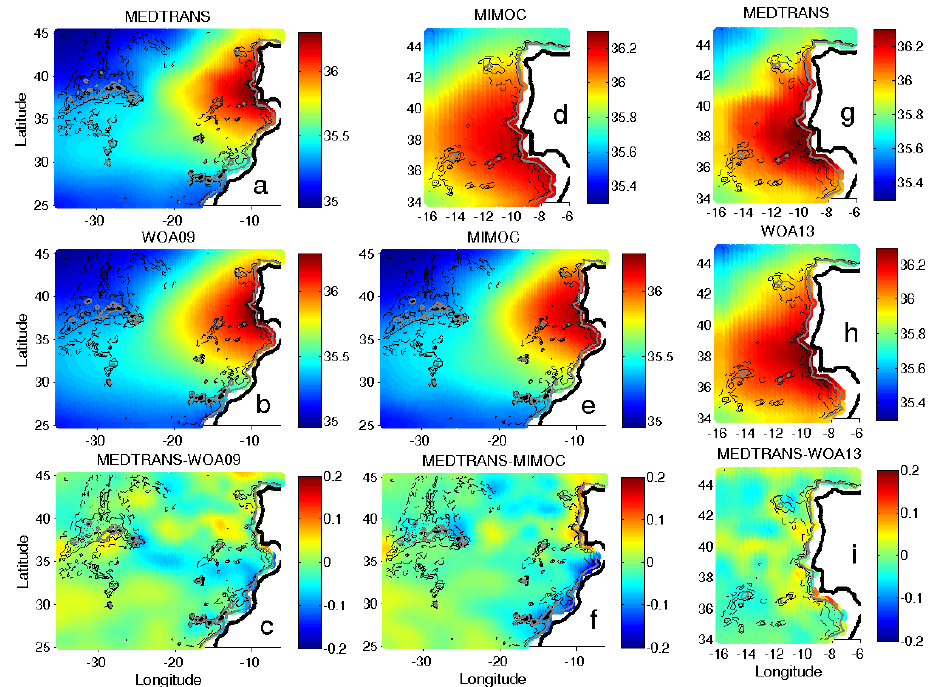
Figure 8. Salinity at 1200m. All regions: (a) MEDTRANS, (b) WOA09, (c) MEDTRANS minus WOA09, (e) MIMOC, and (f) MEDTRANS minus MIMOC. Zoom to the Iberian Peninsula: (d) MIMOC, (g) MEDTRANS, (h) WOA13, and (i) MEDTRANS minus